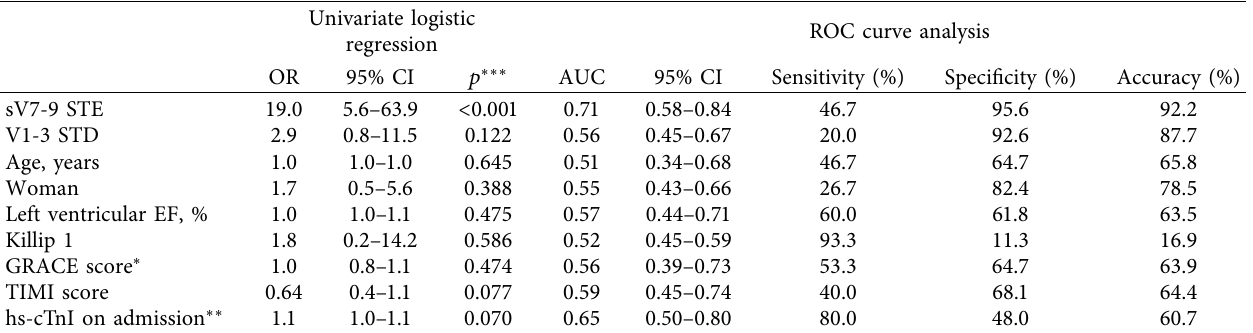
Table 3: Univariate logistic regression analysis and ROC curve analysis for prediction of LCx STEMI-equivalent ACS.